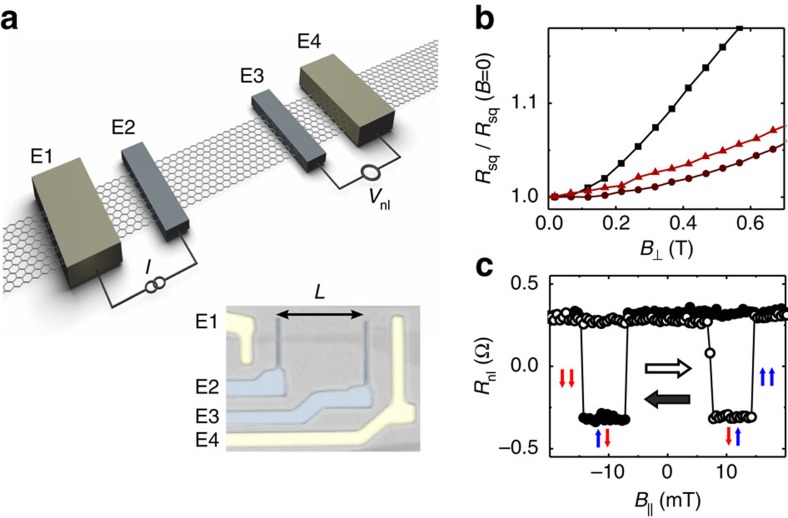
Device schematics and spin transport.(a) Schematic drawing of the lateral non-local spin device geometry showing both the outer normal metallic electrodes (E1 and E4), and the inner ferromagnetic injector (E2) and detector (E3) electrodes. Wiring is shown in the non-local configuration, in which a current I is applied between E1 and E2 and the non-local voltage Vnl is measured between E3 and E4. An optical image of the non-local device used for the measurements shown in this paper is also shown. L=11 μm. (b) Normalized graphene square resistance Rsq as a function of B. Vg−VCNP=2.5, 42.5, 22.5 V (top to bottom). The magnetoresistance is largest for Vg−VCNP. (c) Non-local resistance Rnl≡Vnl/I as a function of a magnetic field applied B in-plane for up and down magnetic field sweeps at gate voltages Vg such that Vg−VCNP=−25 V, with VCNP the position of the CNP. T=300 K and I=10 μA.